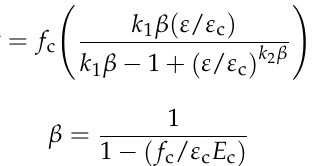
Figure 10. Application of existing stress – strain models to the data of: ( a ) Plain – b; ( b ) CF0.2b; ( c ) CF0.4b; ( d ) PF0.2b; ( e ) PF0.4b; ( f ) CF0.2PF0.2b; ( g ) CF0.2PF0.4b; ( h ) CF0.4PF0.2b; ( i ) CF0.4PF0.4b.